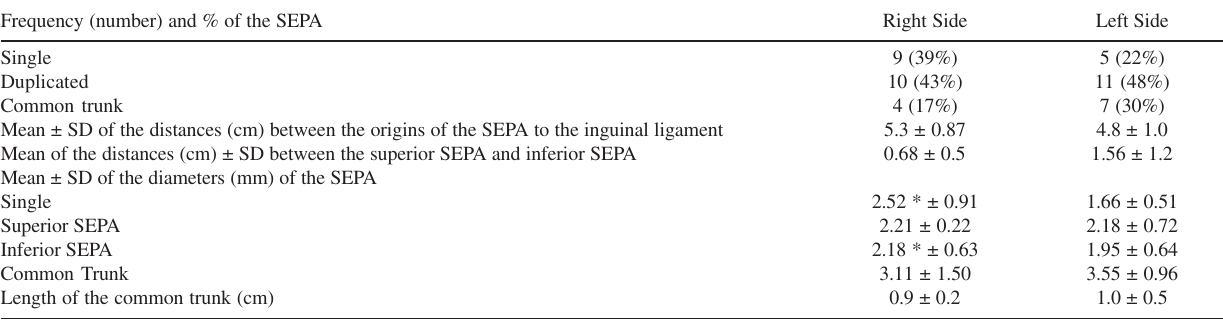
Table 1 - Quantitative data of the superficial external pudendal artery (SEPA) by side of occurrence (46 dissections) Frequency (number) and % of the